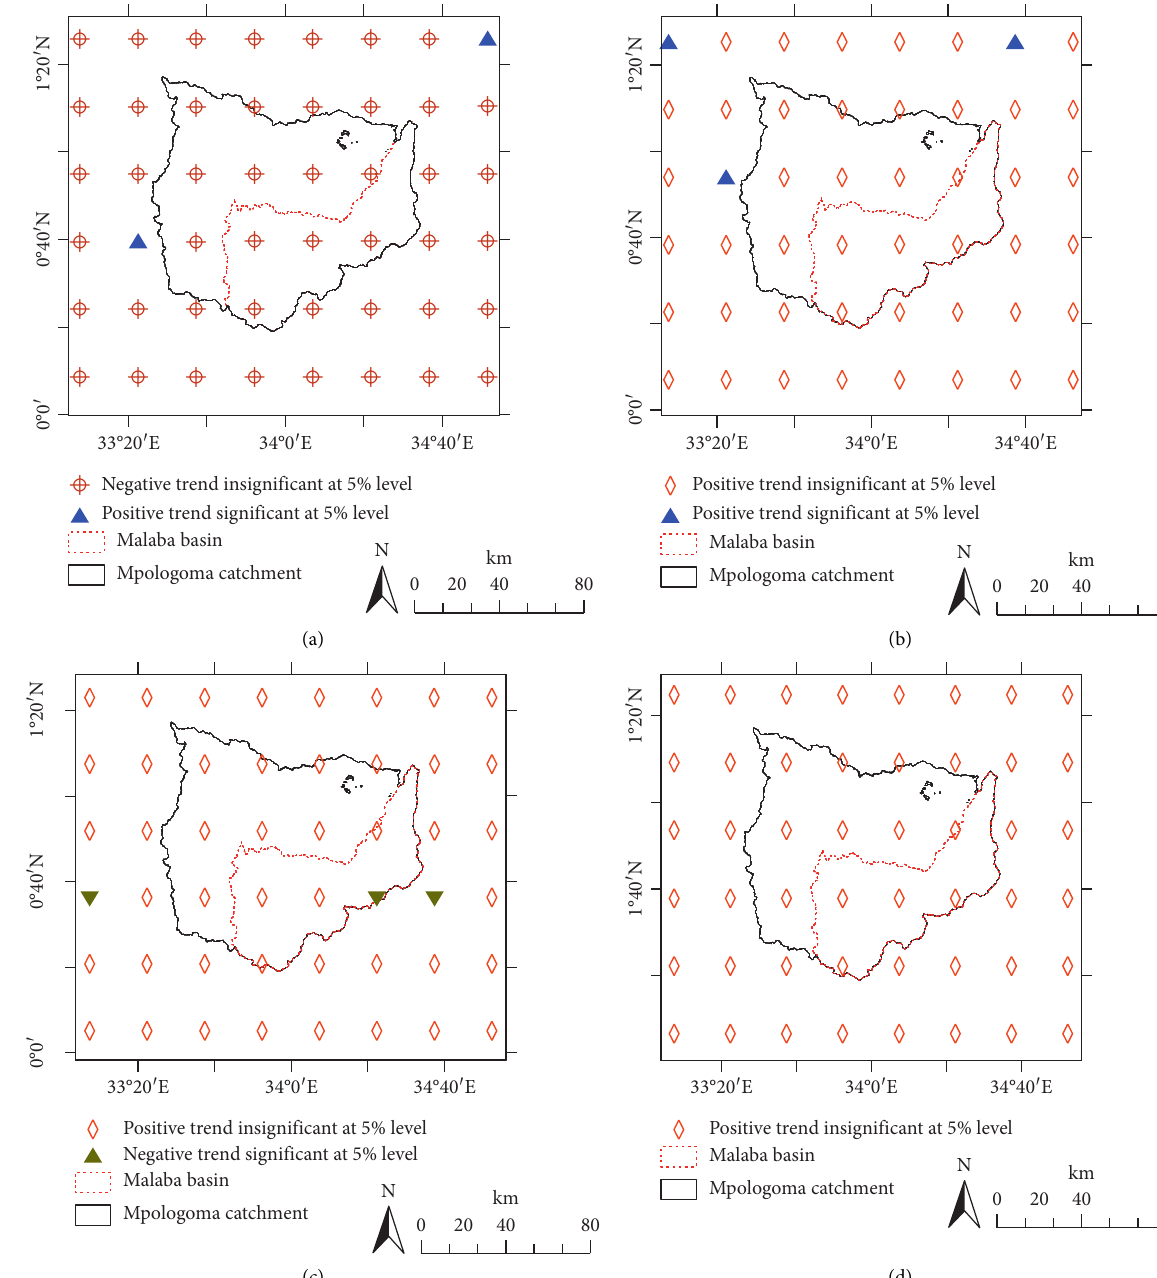
Figure 3: Trend on evapotranspiration: (a) annual, (b) OND, (c) JJAS, and (d)